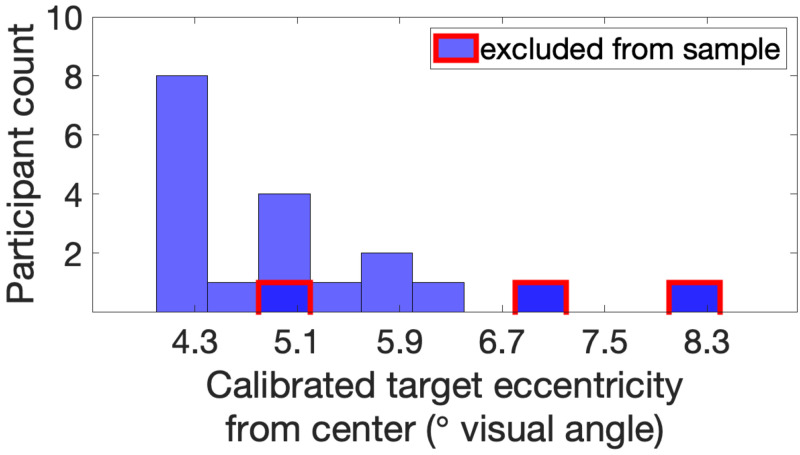
Calibrated target eccentricity and excluded subjects.Across all participants (N = 19), the final target eccentricity used throughout each experiment is shown. Identified in red outline are the three participants excluded for failing to identify PMD periods (detailed in Materials and methods).
Figure 1—figure supplement 1—source data 1.Target eccentricity per participant.